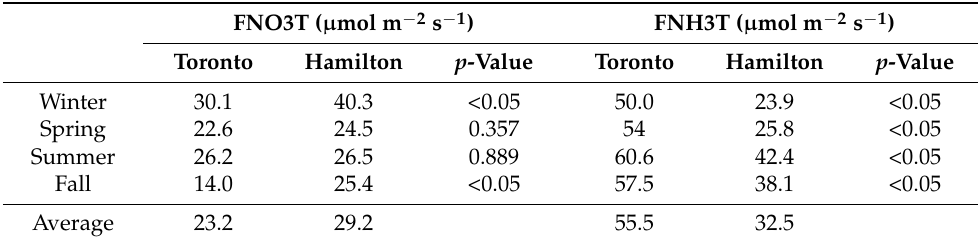
Table 2. Seasonal estimates of N deposition fluxes for HNO 3 and NH 3 calculated for Toronto and Hamilton. The seasonal averages are compared using the ANOVA test to evaluate the significance of their statistical differences. The resulting p -values less than 0.05 indicate a statistically significant difference between the two